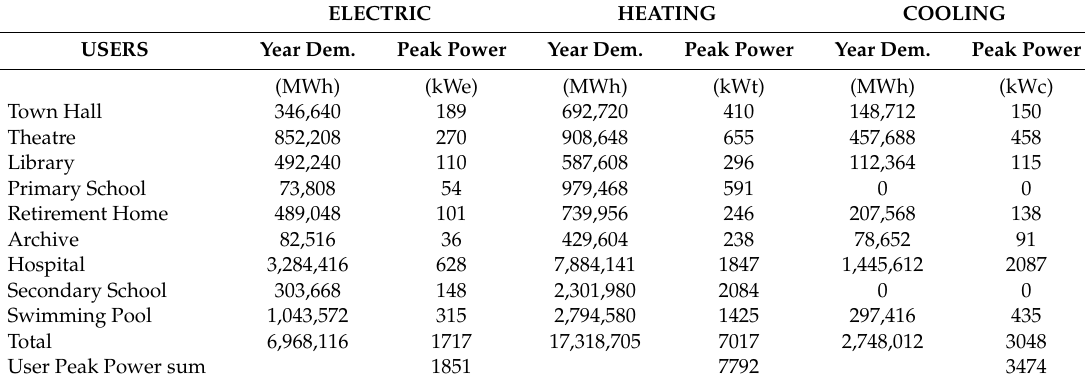
Table 1. User energy demand